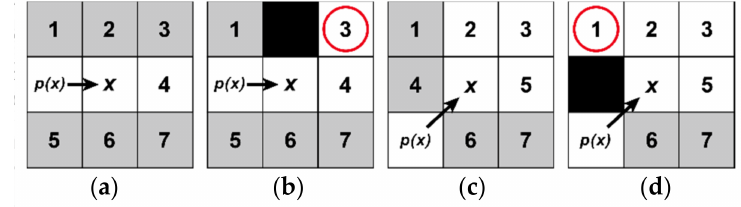
Figure 5. Examples of node pruning. Black arrows mean moving to node x from p ( x ) , black blocks are an obstacle, grey blocks are pruned nodes, white blocks are nodes needed to be considered, and red circles mean the nodes are forced neighbors of the node x